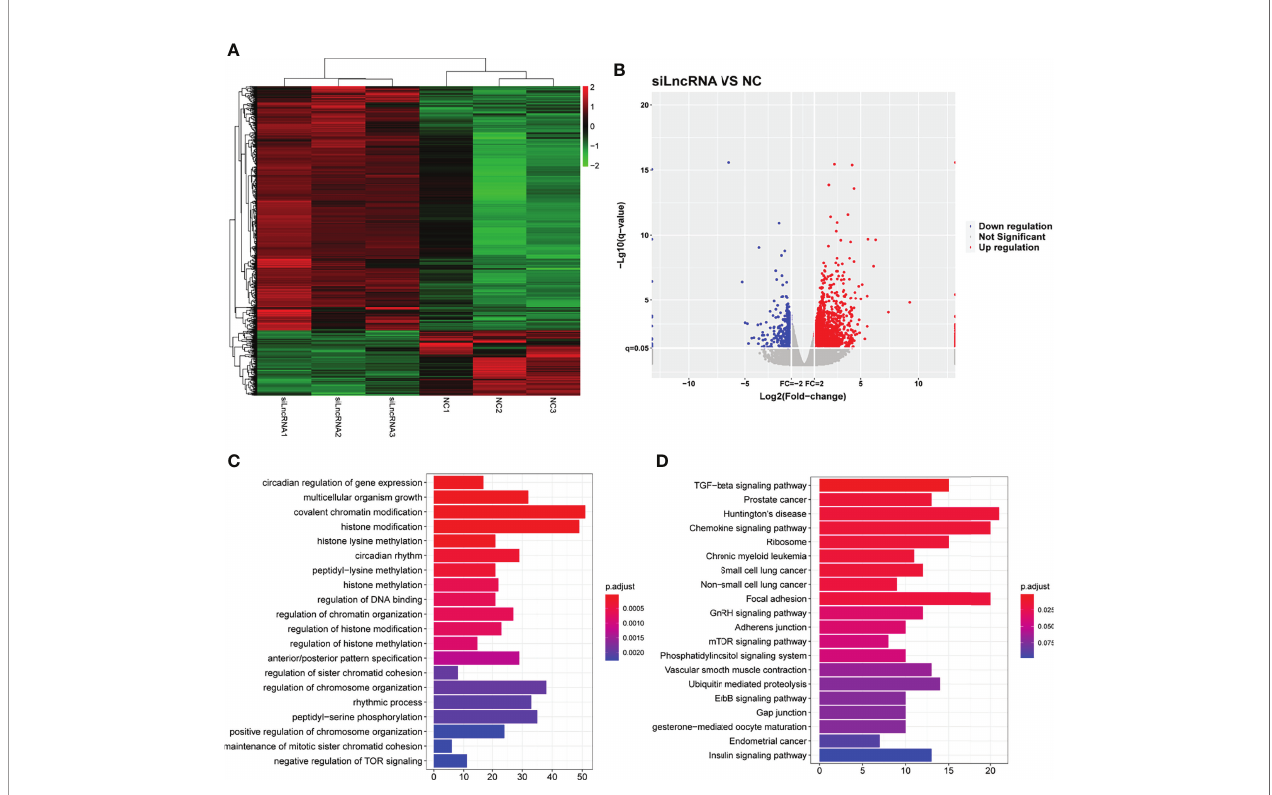
FIGURE 5 | The functional of SNHG1 in downstream mediator. (A) The expression of downstream mRNAs in RAW264.7 cells transfected with lentivirus sh-SNHG1 in a heatmap. (B) The expression of upregulated and downregulated mRNAs in a volcano plot. (C) GO function analysis of differentially expressed mRNAs. (D) KEGG pathway analysis of differentially expressed